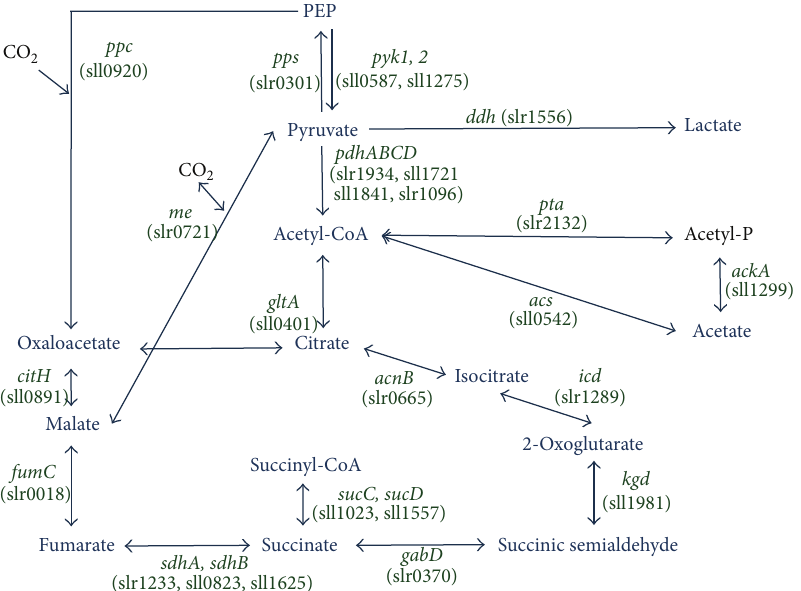
Figure 5: The metabolic map around the TCA and pyruvate metabolism in Synechocystis